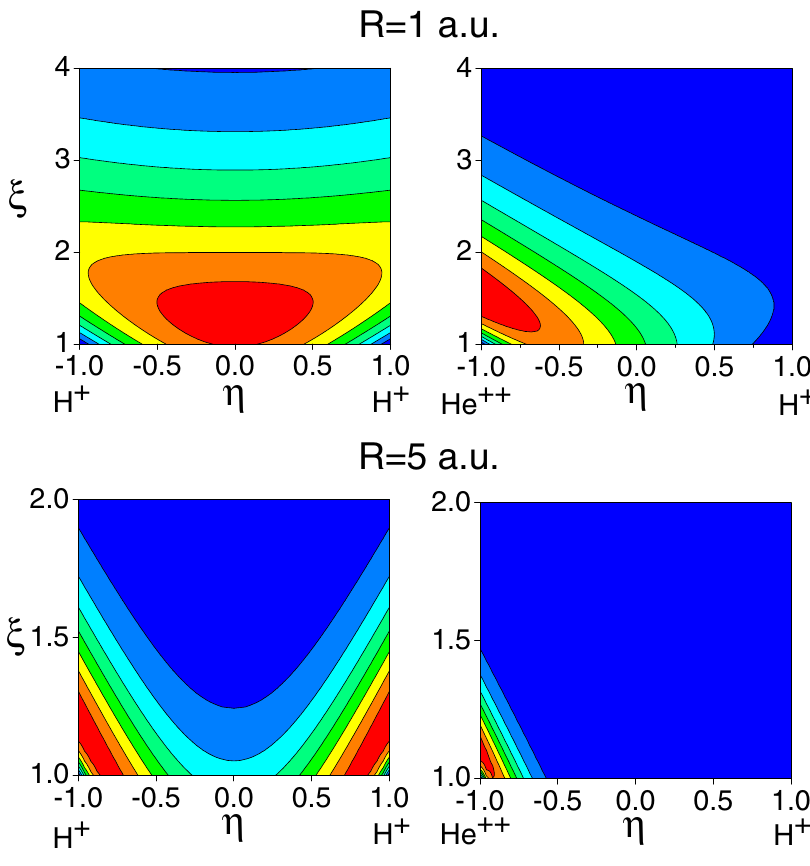
Figure 1. Comparison of the probability densities of the H + (top) and R = 5 a.u. (bottom). The probability density scale is arbitrary with the density decreasing from red to